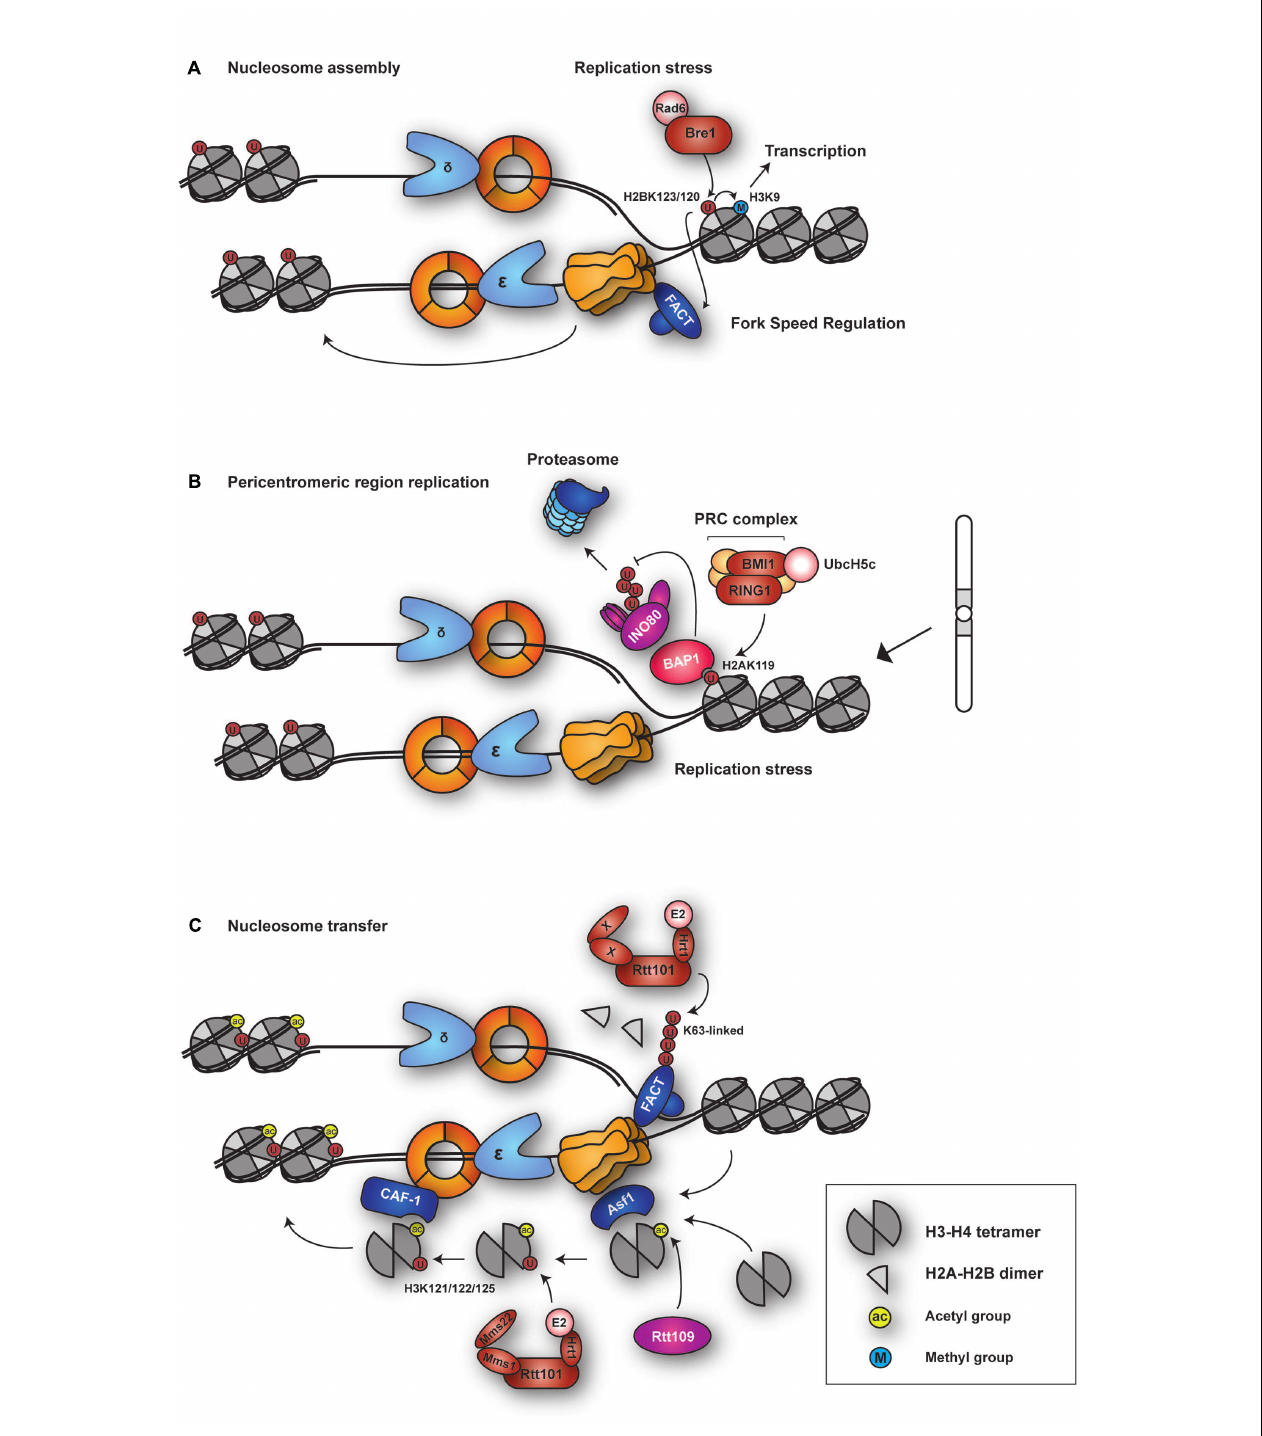
FIGURE 6 | Functions of histone ubiquitylation in DNA replication. (A) Budding yeast E2–E3 complex Rad6-Bre1 is recruited to sites of replication stress for H2B ubiquitylation at K123. H2B Ub regulates fork speed and nucleosome assembly behind the fork. Via H3K9 methylation, it independently contributes to transcriptional regulation. (B) The Polycomb Repressive Complex (PRC) is recruited to sites of replication stress or at problematic sequences to ubiquitylate H2A at K119. H2A Ub recruits BAP1, which maintains fork stability by protecting chromatin-remodeling INO80 complex from proteasomal degradation. (C) The E3 SCF Rtt 101 ubiquitylates H3 at K121, 122, and 125. The reaction is stimulated by acetylation of H3 at K56 by histone acetyltransferase Rtt109. This facilitates transfer of the H3-H4 tetramer to CAF-1 for nucleosome deposition behind the fork. Rtt101 also ubiquitylates the chromatin-reorganizing FACT complex.